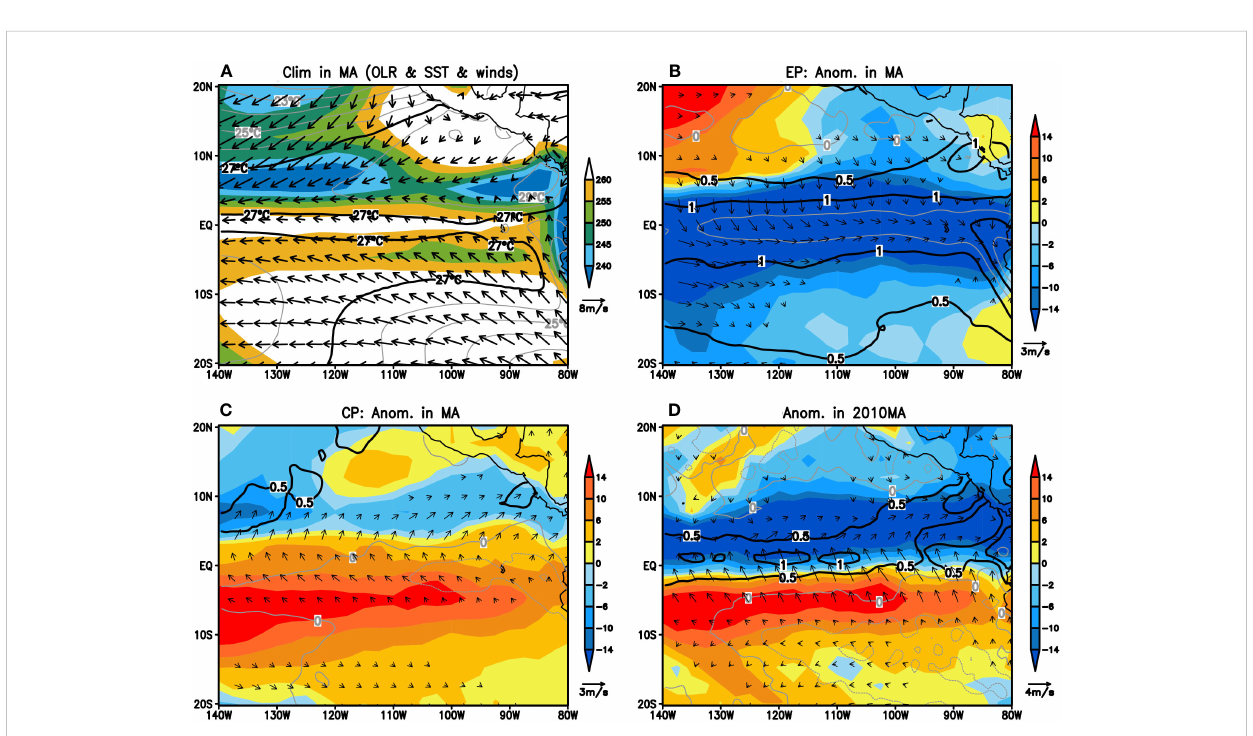
FIGURE 6 As in Figure 5, but color shaded for the outgoing longwave radiation (OLR, units: W/m 2